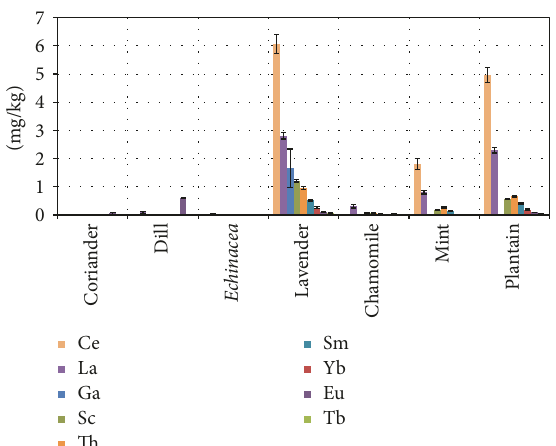
Figure 3: Concentrations of the rare earths in the plant